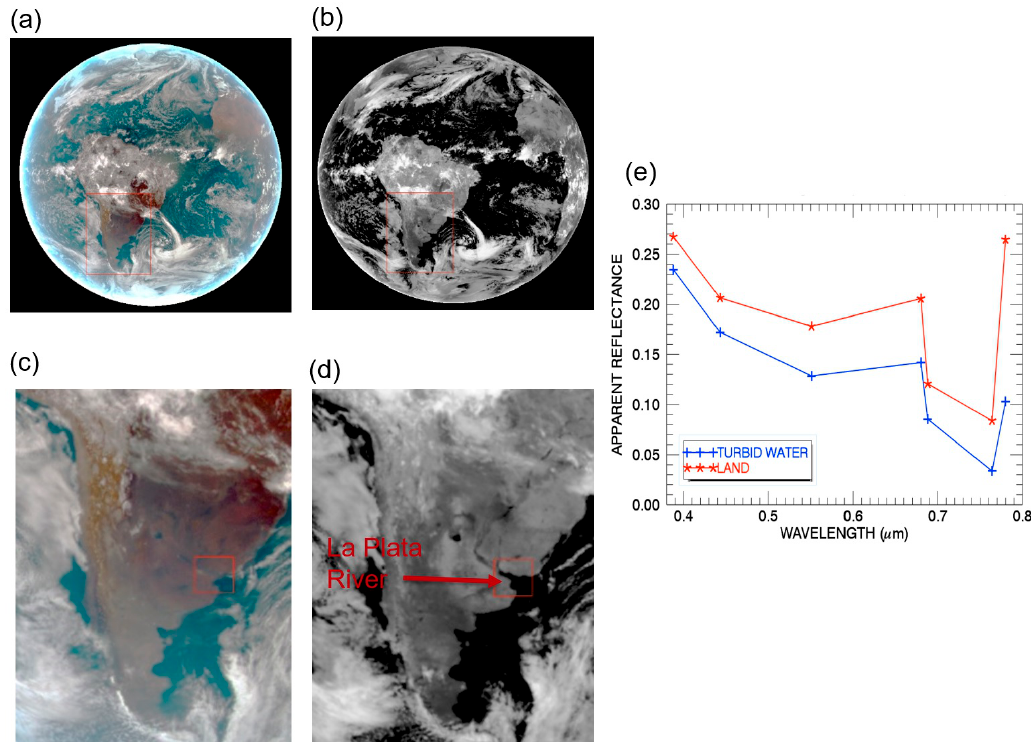
Figure 1. ( a ) The sunlit full disk color image processed from three EPIC channel (Red: 680 nm; Green: 551 nm; Blue: 443 nm) images acquired on 13 March 2013 at UTC 1442; ( b ) The full disk 764-nm channel image; ( c ) The portions of color image over southern part of S. America; ( d ) The portions of the 764-nm image over southern part of S. America; ( e ) Apparent reflectances as a function of wavelength for a turbid river water pixel (blue line marked with ‘+’) and a land pixel (red line marked with ‘*’). Pixels are selected in the red box marked in Panel (C) and (D).